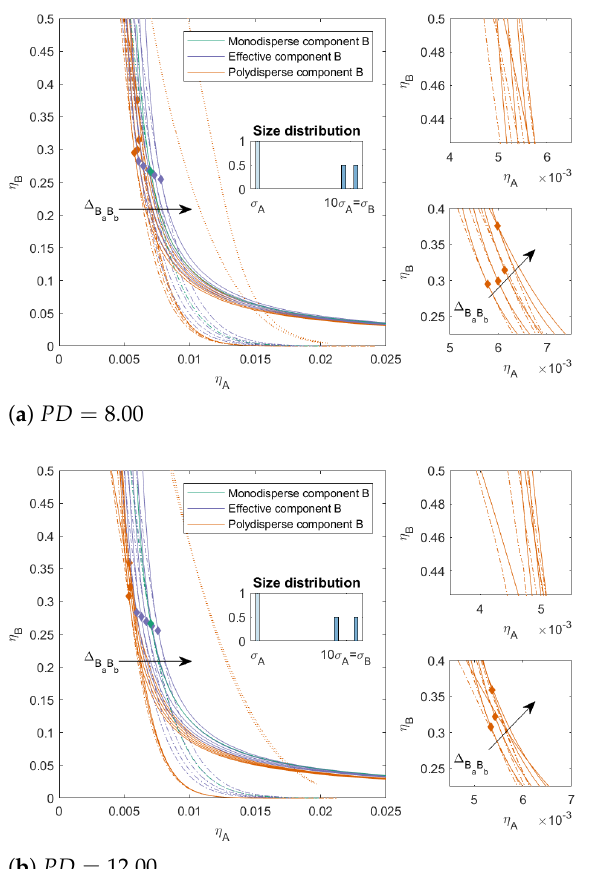
Figure 4. Phase diagram for binary (component A and B ) nonadditive hard sphere mixture with size ratio q = σ A / σ B = 1/10 plotted as a function of the partial packing fractions, η A and η B ; component A is monodisperse, component B is polydisperse ( PD = 8.00 or PD = 12.00). The symbols σ A and σ B refer to the diameters of the species A and B, respectively. The interaction between components A and B is additive, the interaction between the subcomponents B is nonadditive, the nonadditivity parameter ∆ B was varied from − 0.1 to 0.1 with a step size of 0.05 (the arrow indicates increasing a B b ∆ B a B b ). The spinodal (solid line) and binodal (dashed line) meet each other at the plait point (diamond), the three-phase boundary is indicated with a dotted line. The two right-hand smaller figures represent zoomed-in sections of the main